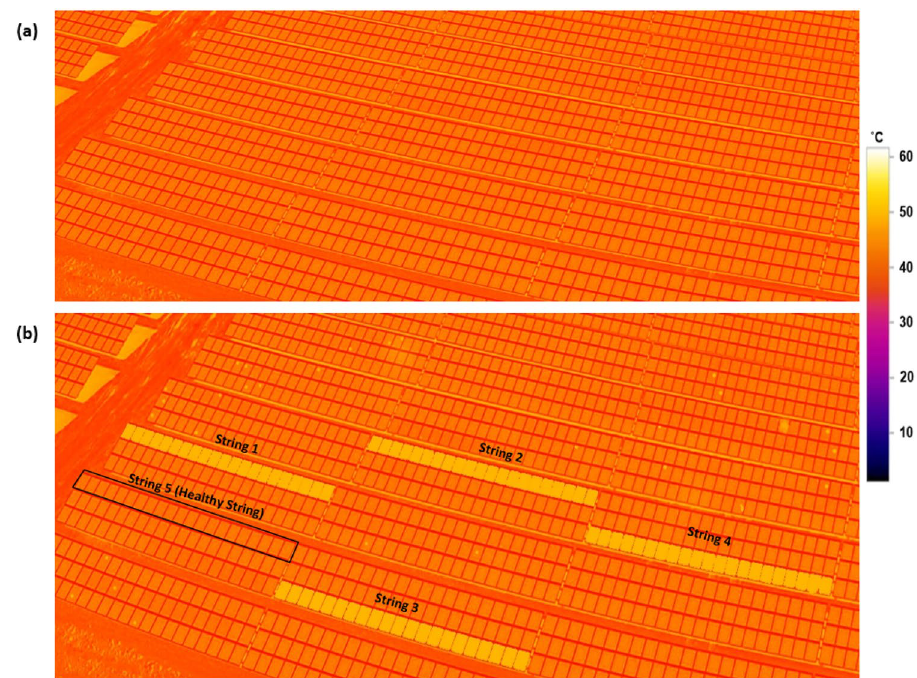
Figure 1. Thermography image of the tested PV strings during nigh-time. ( a) Image taken on 01/08/2019, first day of PV operation (ambient temperature 34 °C). ( b) Image taken on 03/08/2020, after 1-year of operation (ambient temperature 35 °C). The thermal image is taken using DJI Mavic 2 Enterprise Advanced drone with thermal sensitivity ± 2